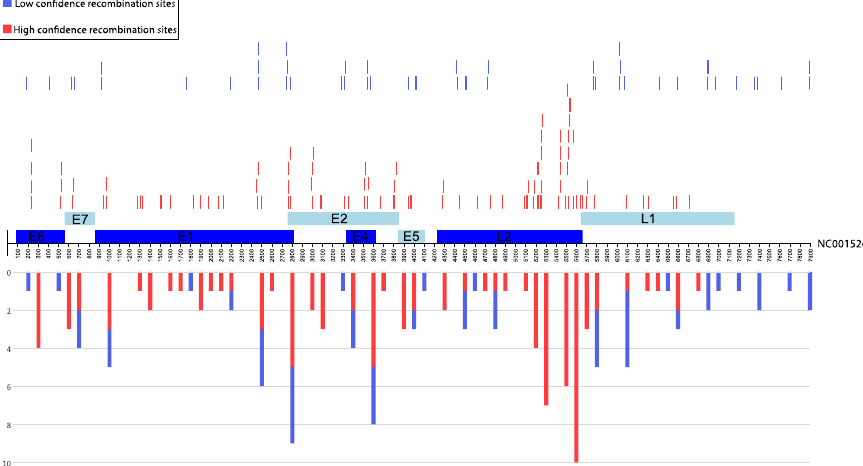
Figure 4. Recombination sites on the HPV16 genome. Higher confidence and lower confidence recombination sites are shown as red and blue vertical lines, respectively, above the genome diagram. The stacked histogram below the genome diagram shows the relative abundance of higher and lower confidence recombination sites per 100 nucleotides. L2 seems to be the most frequently recombined genomic region, followed by E1 and E2. The graphical representation was made using the reference sequence NC_001526 that is depicted as a linear chromosome (although it is actually circular) for visualization purposes.